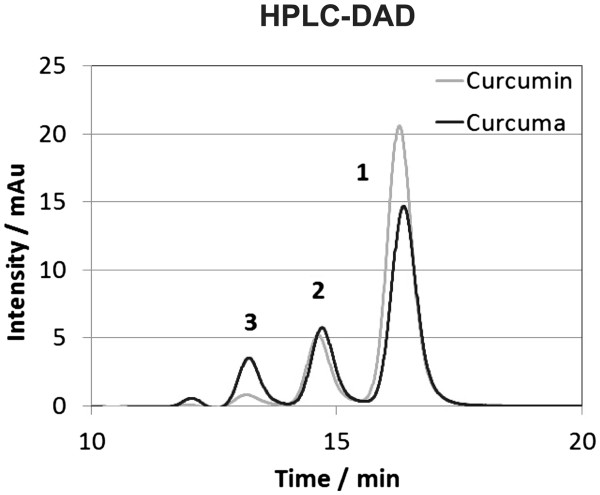
Analysis of the composition of the curcuma DMSO extract (black line) and the reference substance curcumin (grey line, >94% purity with demethoxycurcumin and bisdemethoxycurcumin as impurity) in DMSO by HPLC-DAD (detection wavelength 425 nm). The three peaks were identified as curcumin (1, retention time 16.9 min), demethoxycurcumin (2, retention time 15.4 min) and bisdemethoxycurcumin (3, retention time 13.7 min) by their (M + H)+ ions in the HPLC/MS analysis.